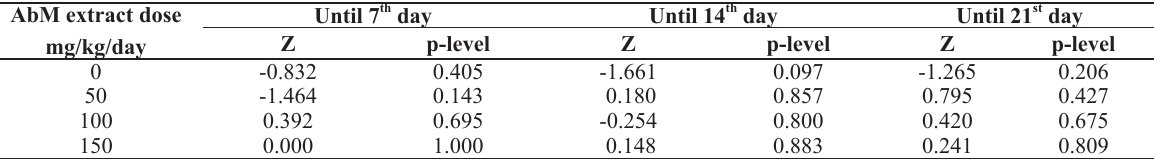
The differences in survival of bees between groups fed with syrup and candy (Mann-Whitney U test).